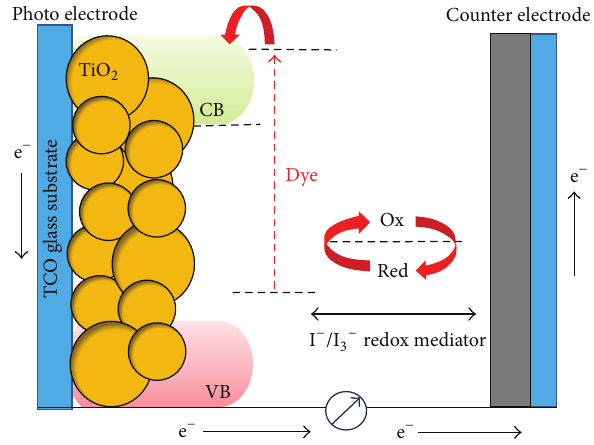
Figure 1: Schematic diagram of